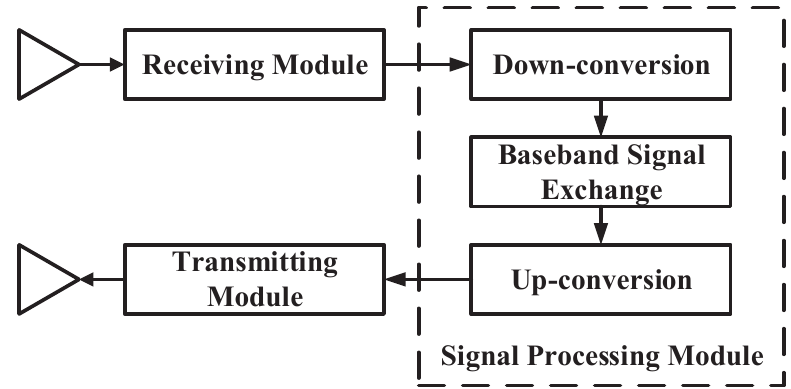
Figure 2. Principle diagram of chirp-mismatch echo signal